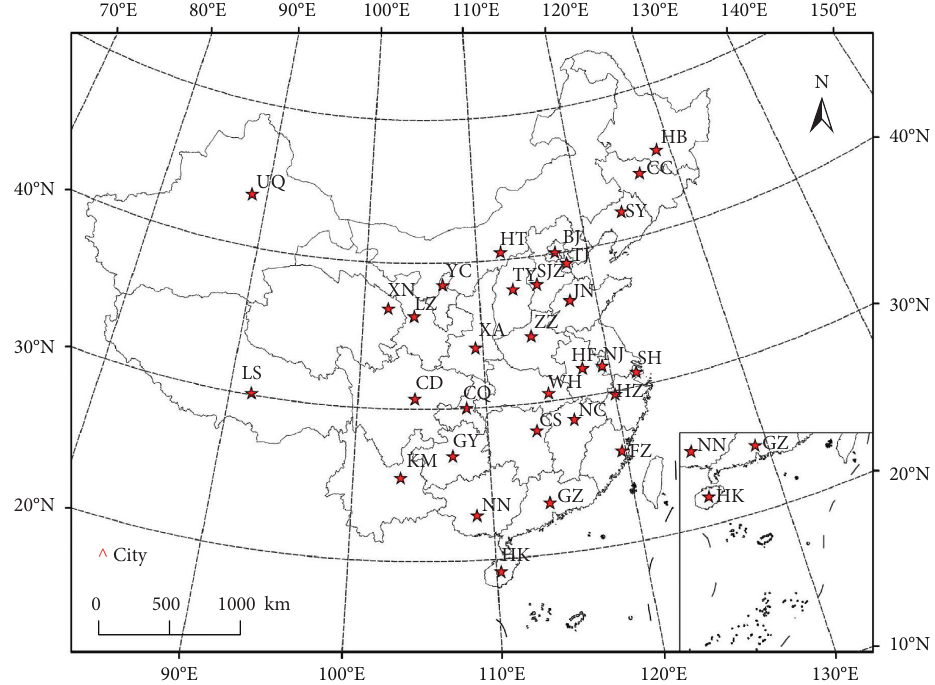
Figure 1: The locations of 31 provincial capital cities in mainland China. Note: Beijing (BJ), Changchun (CC), Changsha (CS), Chengdu (CD), Chongqing (CQ), Fuzhou (FZ), Guangzhou (GZ), Guiyang (GY), Haikou (HK), Hangzhou (HZ), Harbin (HB), Hefei (HF), Hohhot (HT), Jinan (JN), Kunming (KM), Lanzhou (LZ), Lhasa (LS), Nanchang (NC), Nanjing (NJ), Nanning (NN), Shanghai (SH), Shenyang (SY), Shijiazhuang (SJZ), Taiyuan (TY), Tianjin (TJ), Urumqi (UQ), Wuhan (WH), Xi’an (XA) and Xining (XN), Yinchuan (YC), and Zhengzhou